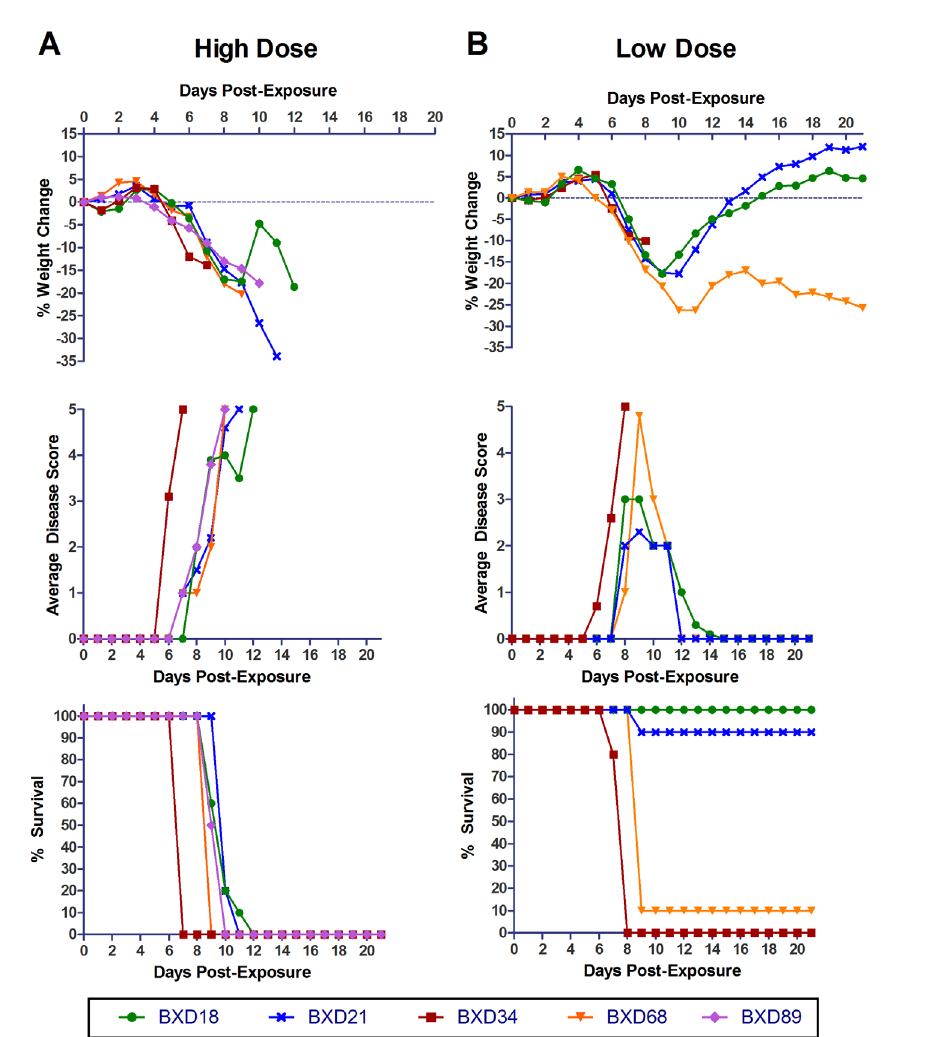
Figure 3. Exposure of susceptible BXD strains to high (a) and low (b) doses of aerosolized MA-EBOV. Weight loss, clinical disease score and survival are shown for BXD18, BXD21, BXD34, and BXD68 exposed to high (1345-2408 pfu) or low (52 pfu) doses. BXD89 was exposed to a high dose only (n = 10 per mouse